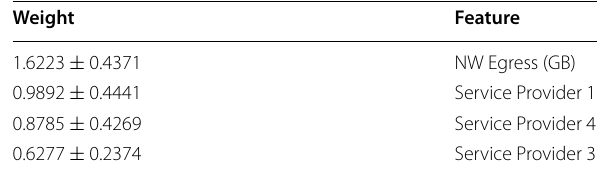
Table 6 Permutation importance feature rank for the cost model of video streaming service Weight